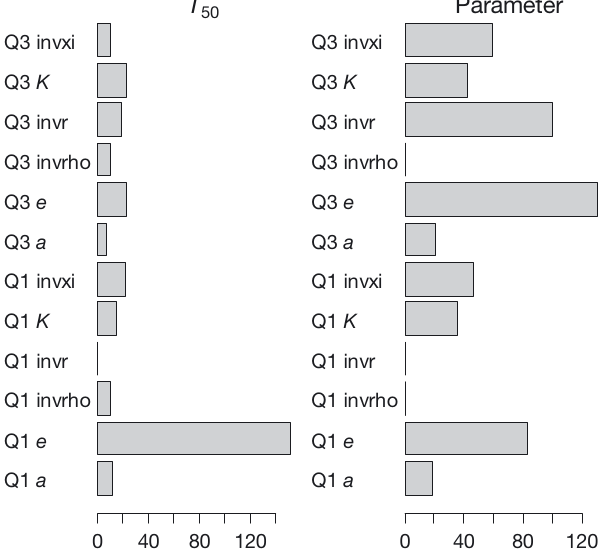
Fig. 11. Variability of the model output depending on the range of each epidemiological parameter. Left: relative dif- ference (%) of the time to obtain 50% mortality ( T 50 ) when the most probable value of each epidemiological parameter at high temperature was replaced by the first (Q1) or third (Q3) quartile value of its observed experimental distribution in the REF scenario. Right: relative difference (%) between the most probable and Q1 or Q3 value of each parameter. Parameter name corresponds to the simulation with the corresponding Q value of the parameter’s observed experi- mental distribution. See Fig. 10 for abbreviations